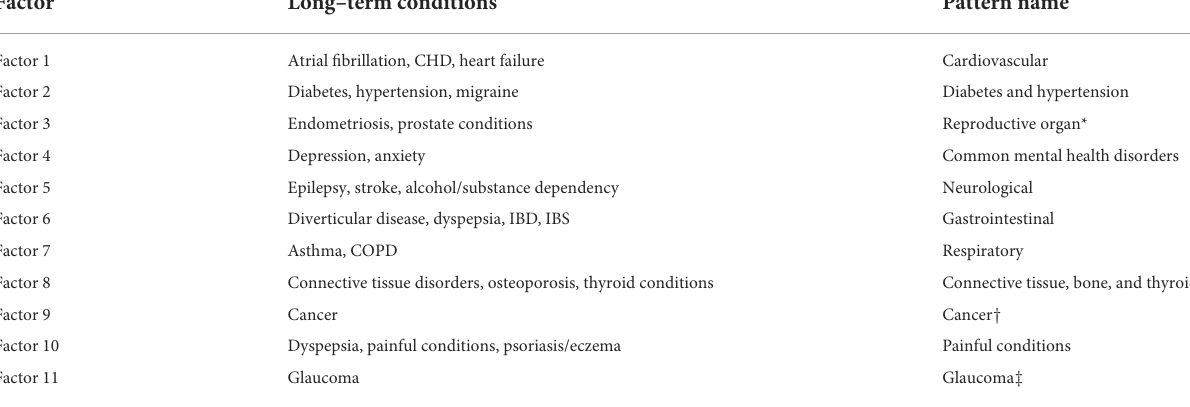
TABLE 3 Multimorbidity patterns identified using exploratory factor analysis ( N =